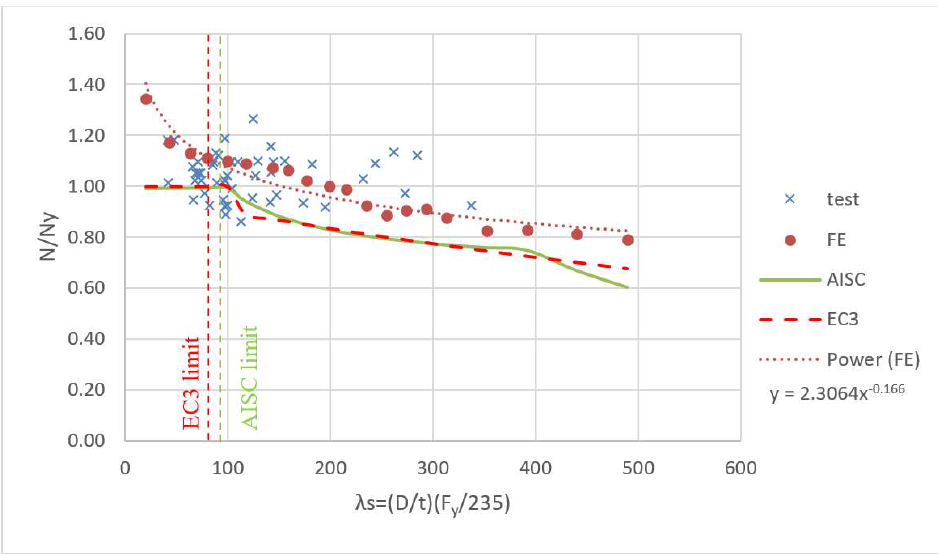
Figure 17. Comparison of normalized static axial load versus section slenderness between experimental results by others, FE by authors, and the predicted values of AISC and EC3 standards for HSS-S460.